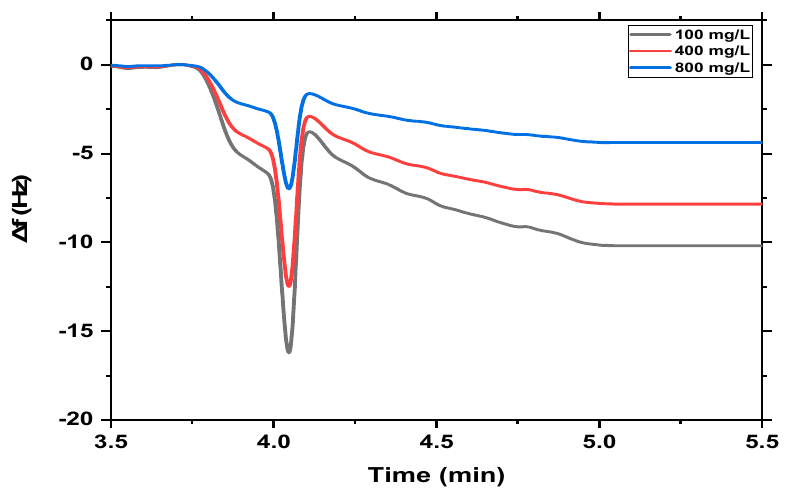
Figure 6. The real-time detection of different concentrations of MB dye (100 mg/L, 400 mg/L, and 800 mg/L) on the surface of the MgFe 2 O 4 NPs nanosensor at room temperature.